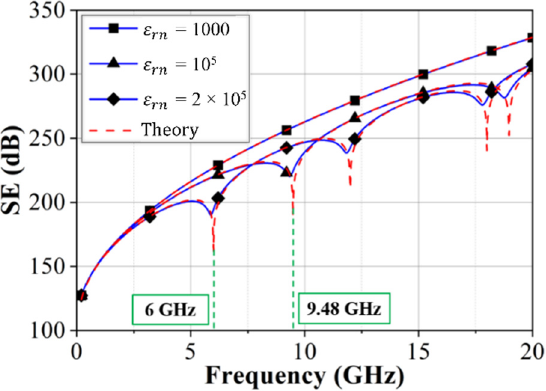
Figure 9. Comparison of SE with different dielectric permittivity levels for a double layer (Cu-6 µm/ Ins(cid:4666)𝜀 (cid:2928)(cid:2924) (cid:4667) -50 µm/Cu-6 µm) shielding